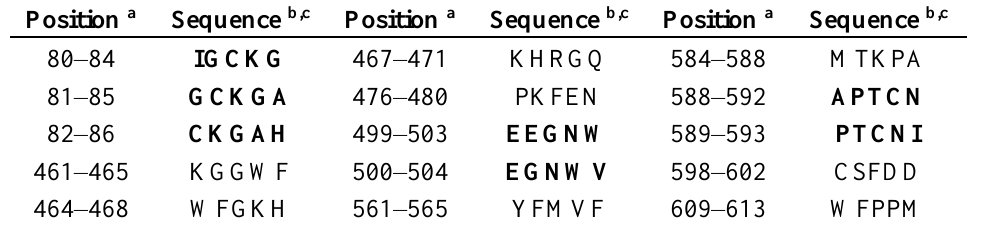
Table 1. Peptide profile of EBV EBNA1 protein primary sequence vs. the human proteome: the unique EBNA1 identity spots at the pentapeptide